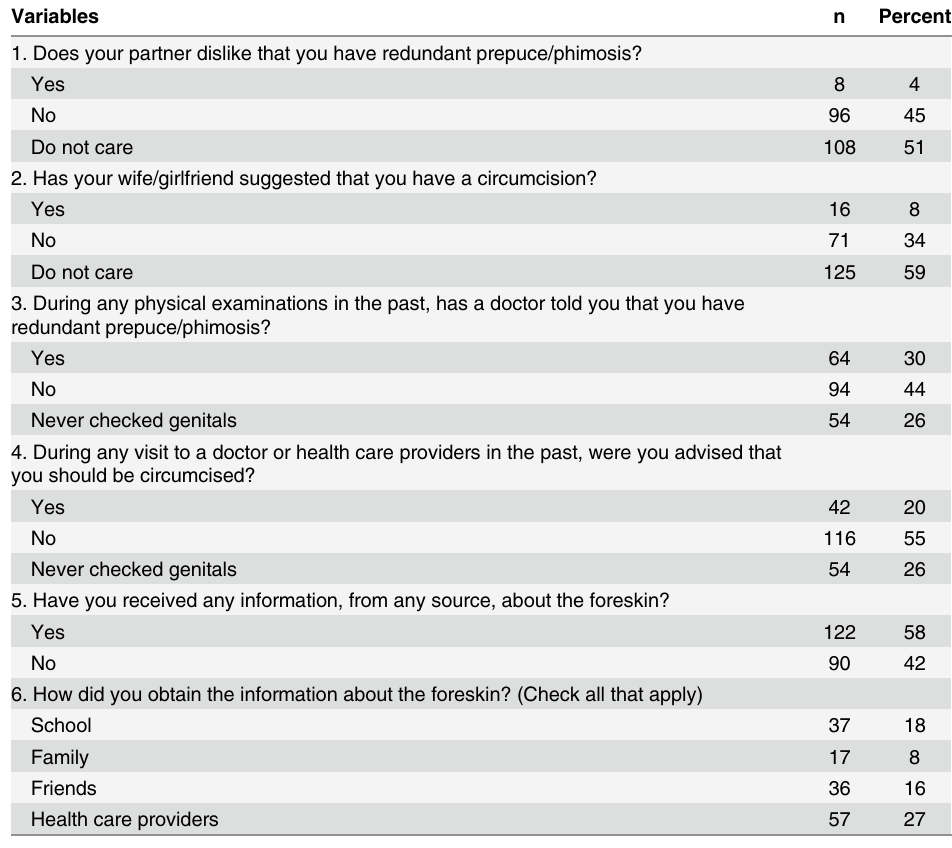
Table 3. The attitude of patients ’ partner and doctor toward redundant prepuce/phimosis and the approaches that participants used to obtain foreskin knowledge. Variables